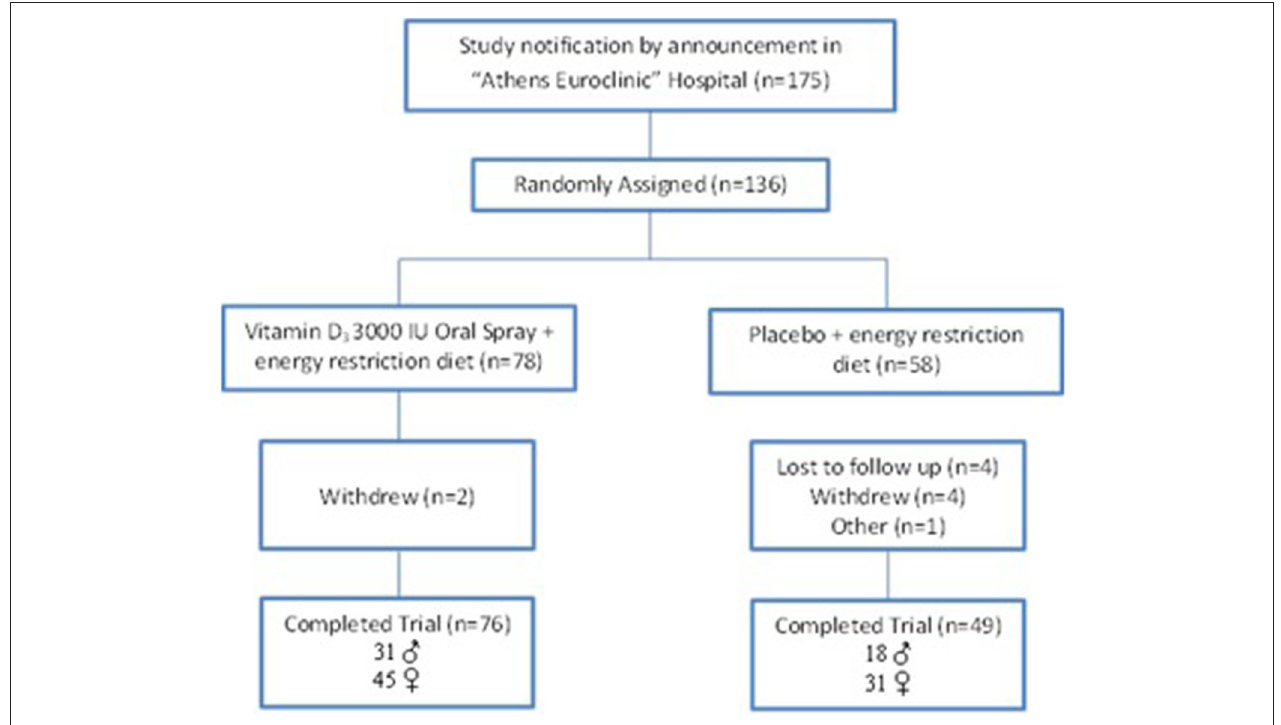
FIGURE 1 | Flow diagram of the study.